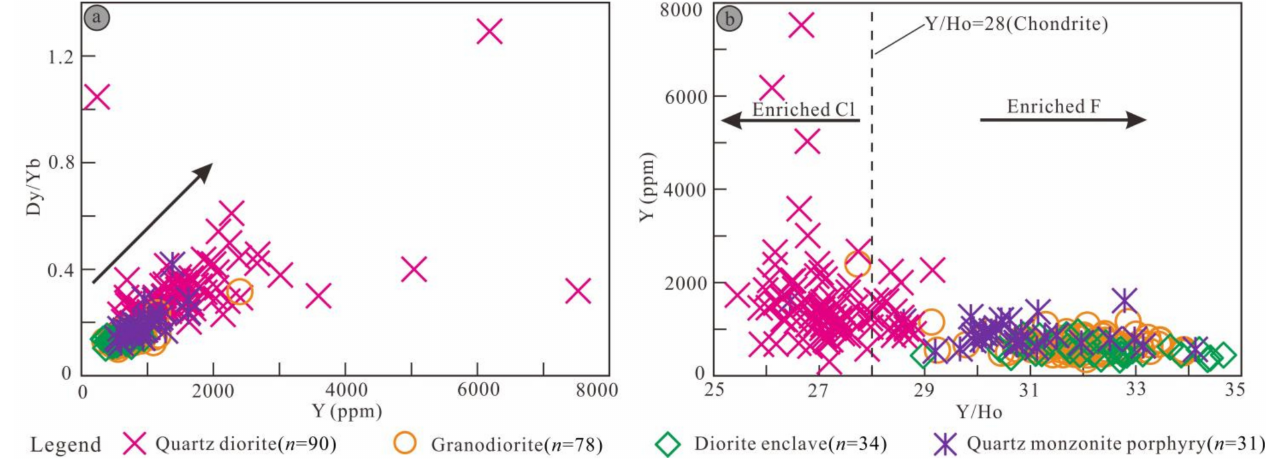
Figure 20. The metallogenic potential discrimination diagrams of zircon trace elements from Yangla granitoid plutons. The dioritic enclaves, granodiorite, and quartz monzonite porphyry zircons data from Ref. [3]. ( a ) the binary diagram of Dy/Ce vs. Y and ( b ) the binary diagram of Y vs